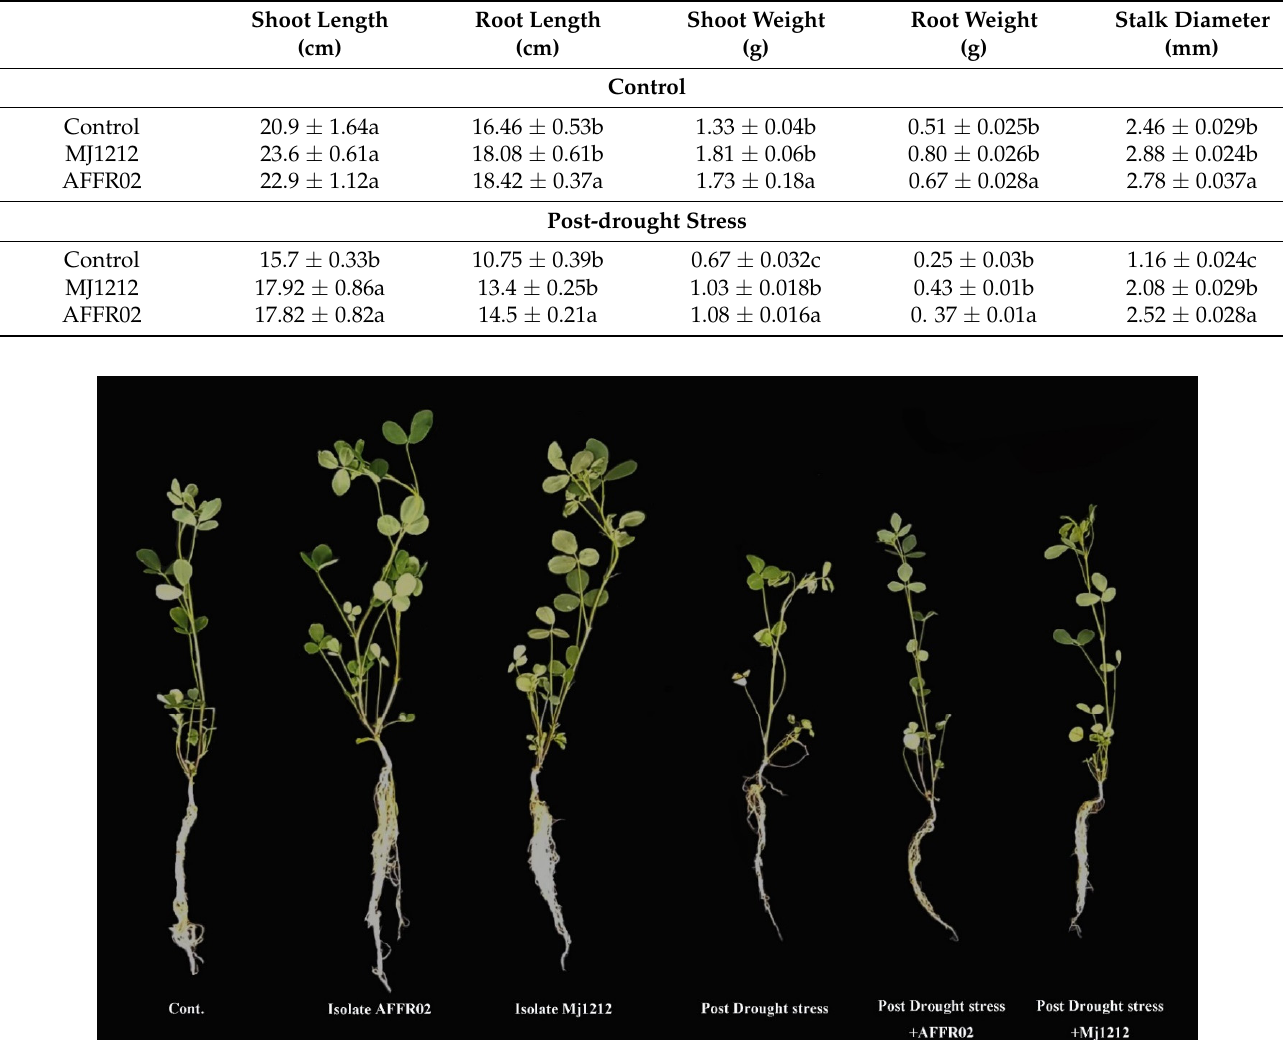
Table 2. Effect of isolate AFFR02 and MJ1212 on chlorophyll content (SPAD), chlorophyll A ( Chl a ), chlorophyll B ( Chl b ), and total carotenoid (CART) of alfalfa plants under normal and post- drought stress. Each value in the table is the mean ± standard deviation of three replicates. Mean in columns followed by different letters describes significant difference by using Duncan’s multiple range test at p > 0.05.